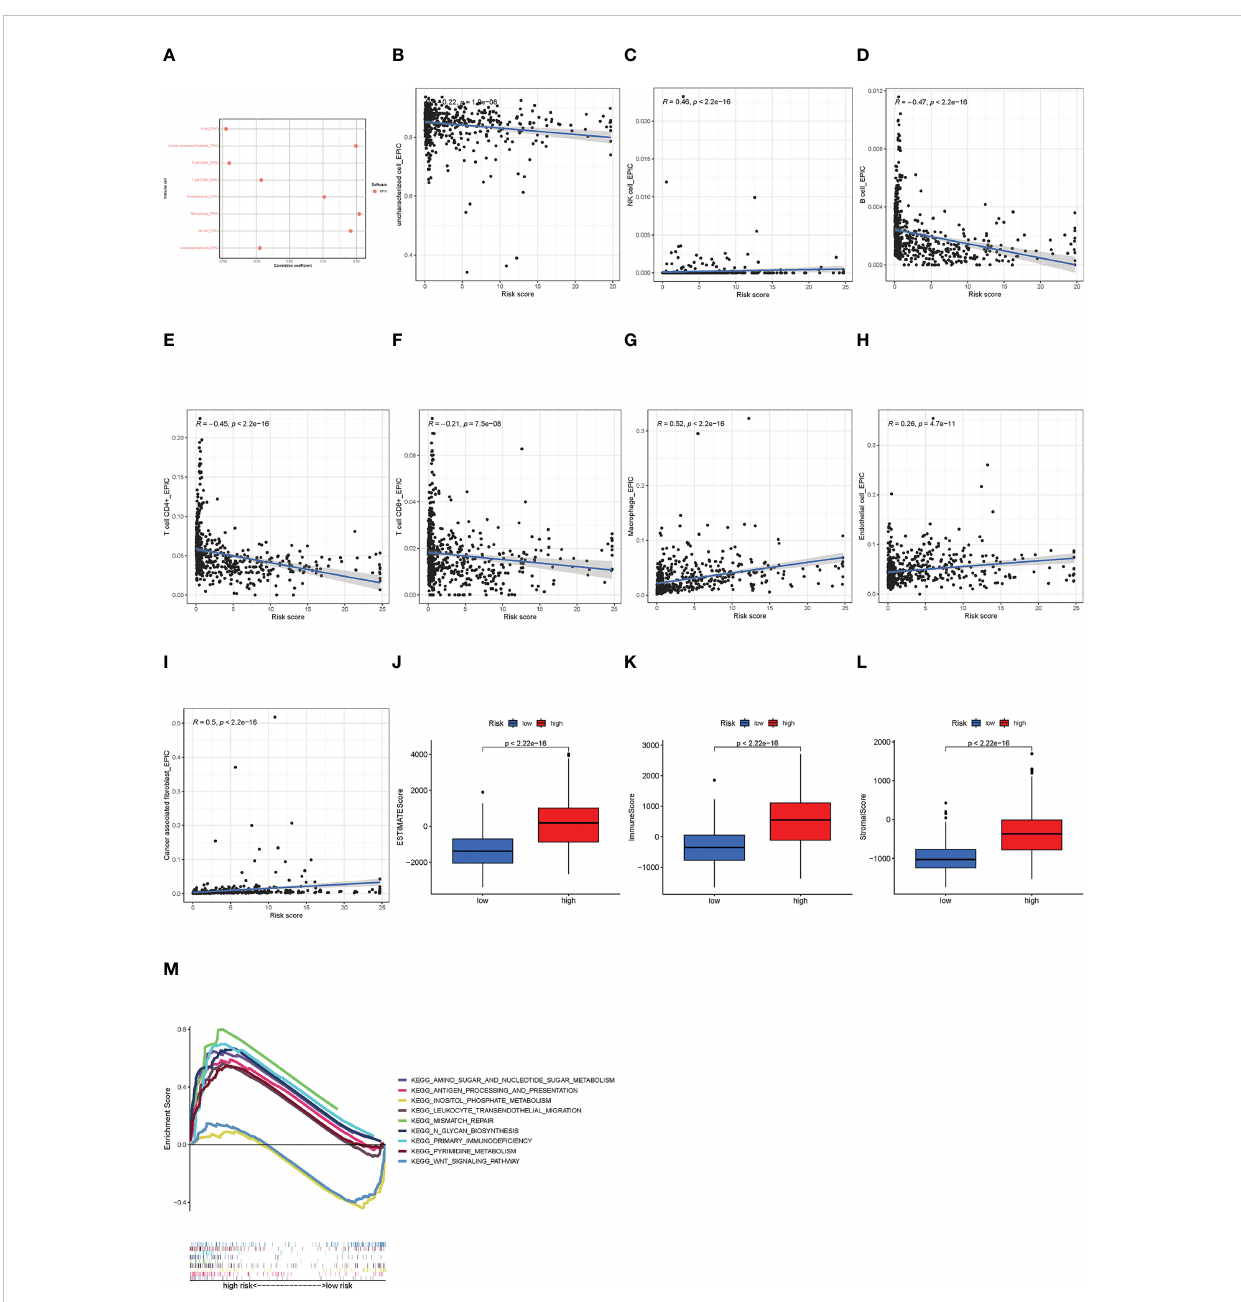
FIGURE 6 The immune analysis of high- and low-risk groups. (A) The immune cell bubble of risk groups. (B – I) The correlation of immune cell and risk scores at EPIC. (J – L) The TME scores between risk groups. (M) GSEA of the eight pathways signi fi cantly enriched in the high-risk group and two enriched in the low-risk